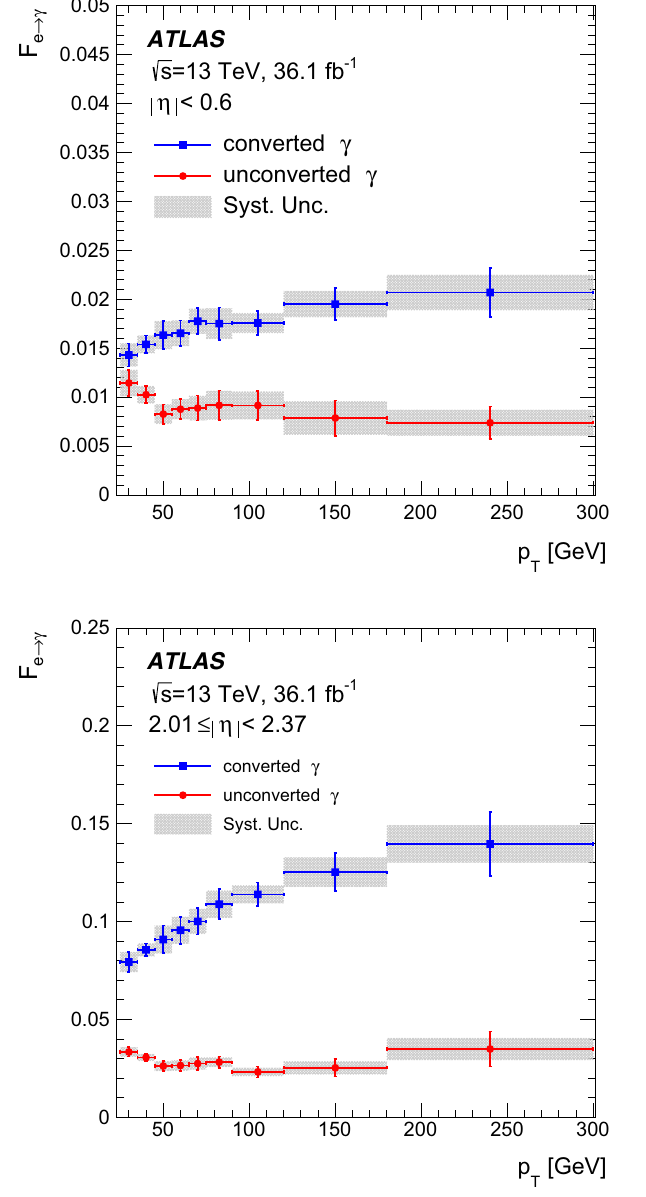
Fig. 16 Evolution of the e → γ fake-rate as a function of p T for electrons reconstructed as converted (blue squares) and unconverted (red circles) photons in the | η | bins 0.0–0.6, 1.15–1.37 and 2.01–2.37.